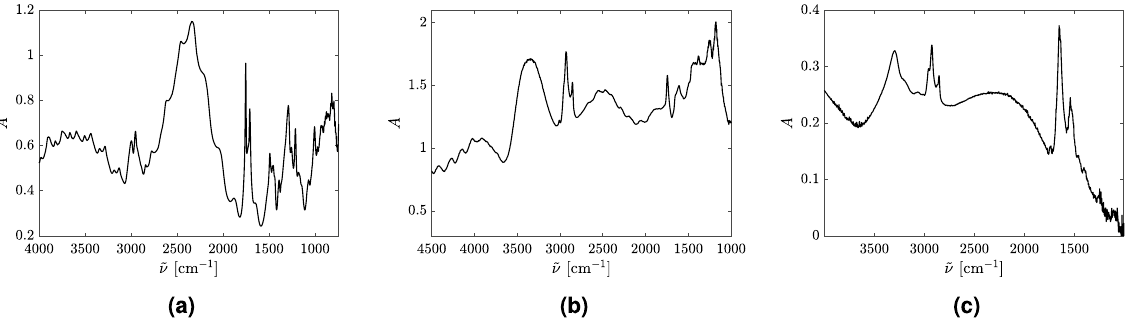
Figure 2. Absorbance spectra of ( a ) a PMMA-sphere 22 ( b ) a Juniperus Excelsa pollen grain 22 and ( c ) a human lung cancer cell 10 . In order not to introduce spurious features into the spectra that may result from using a correction algorithm, and in order to highlight the original appearance of the spectra, all three spectra shown are uncorrected, raw spectra. The tiny, sharp features seen in the spectrum in frame ( c ) are mostly due to noise and counting statistics; they are not reproducible